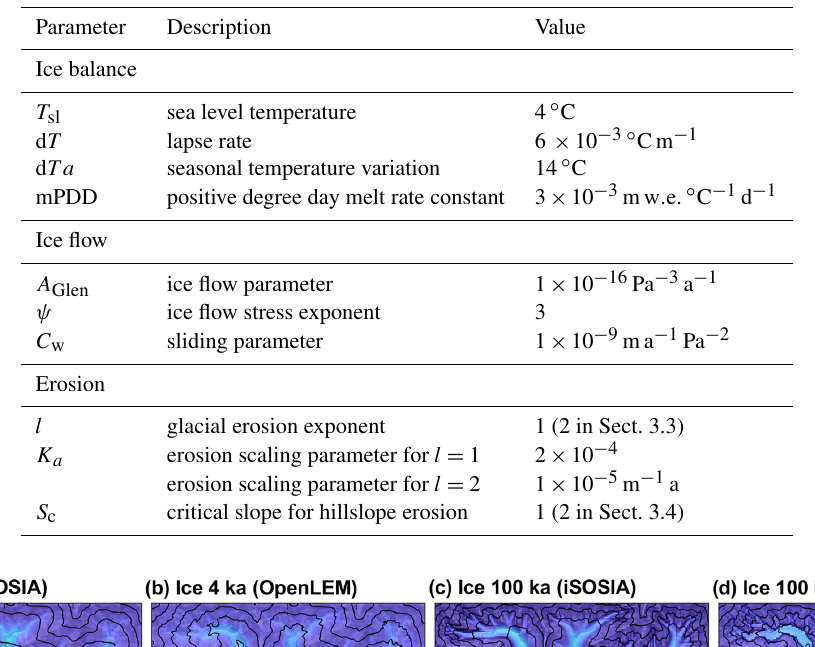
Table 1. Parameters related to glacial dynamics in iSOSIA.